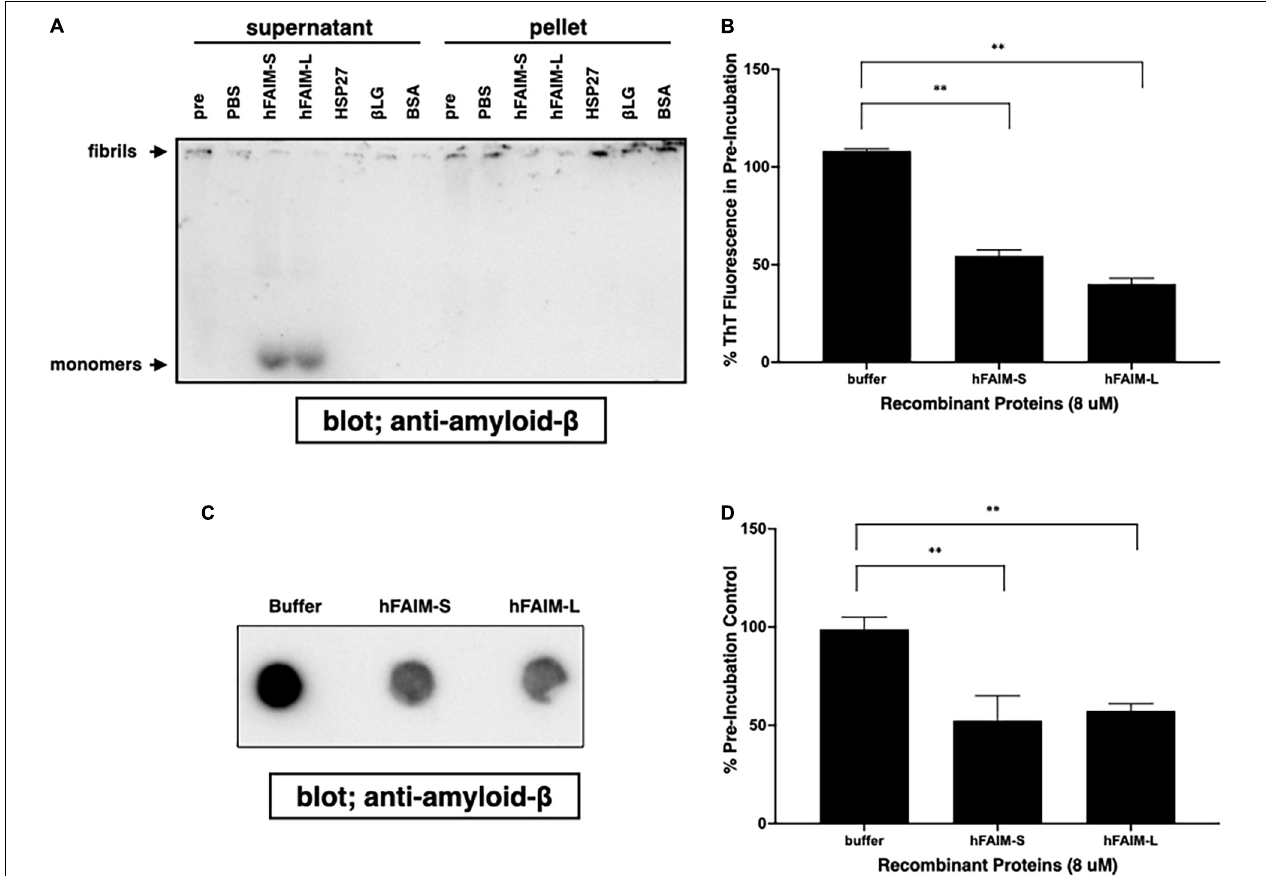
FIGURE 4 | Recombinant FAIM solubilizes amyloid- β fibrils and generates monomers in a cell-free system. Pre-formed amyloid- β 1-42 (A β 42) fibrils (0.5 µ M) were incubated with or without 5 µ M recombinant FAIM, HSP27, β LG, BSA or PBS. for 2.5 hr followed by sedimentation analysis (A), Thioflavin T (ThT) staining (B) , and filter trap assay (C) to evaluate the levels of A β 42 species. For sedimentation analysis, samples were fractionated into supernatant and pellet fractions by centrifugation at 14,000 × g for 10 min. Pellets were washed twice with PBS, and then native-PAGE gels were used because SDS partially solubilizes A β 42 fibrils and produces A β 42 monomers. Pre; pre-incubation with proteins. (D) The trapped fibril levels in (C) were quantified by densitometry, and the data from three independent experiments are shown as percent of pre-incubation control. The data are expressed as mean ± SEM. A two-tailed, unpaired Student’s t -test was used to calculate p -values. Representative data from at least three independent experiments are shown. ∗∗ p <